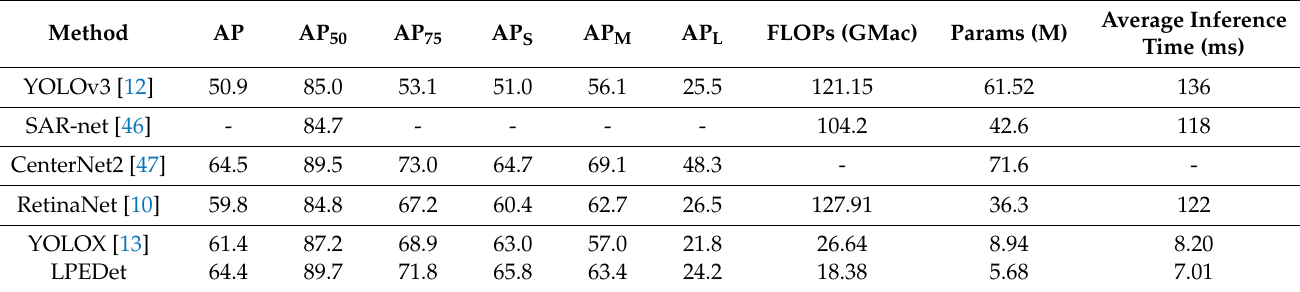
Table 6. Comparison of the latest SAR target detection methods on HRSID.